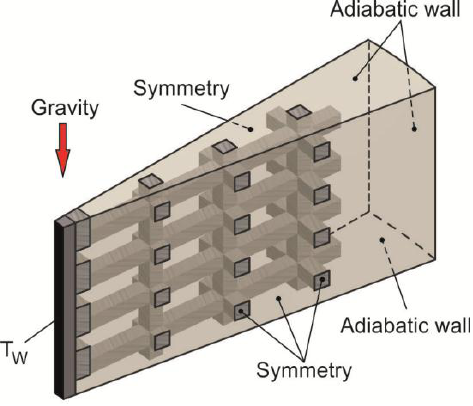
Figure 3. Boundary conditions used for the analyzed heat exchanger configuration.